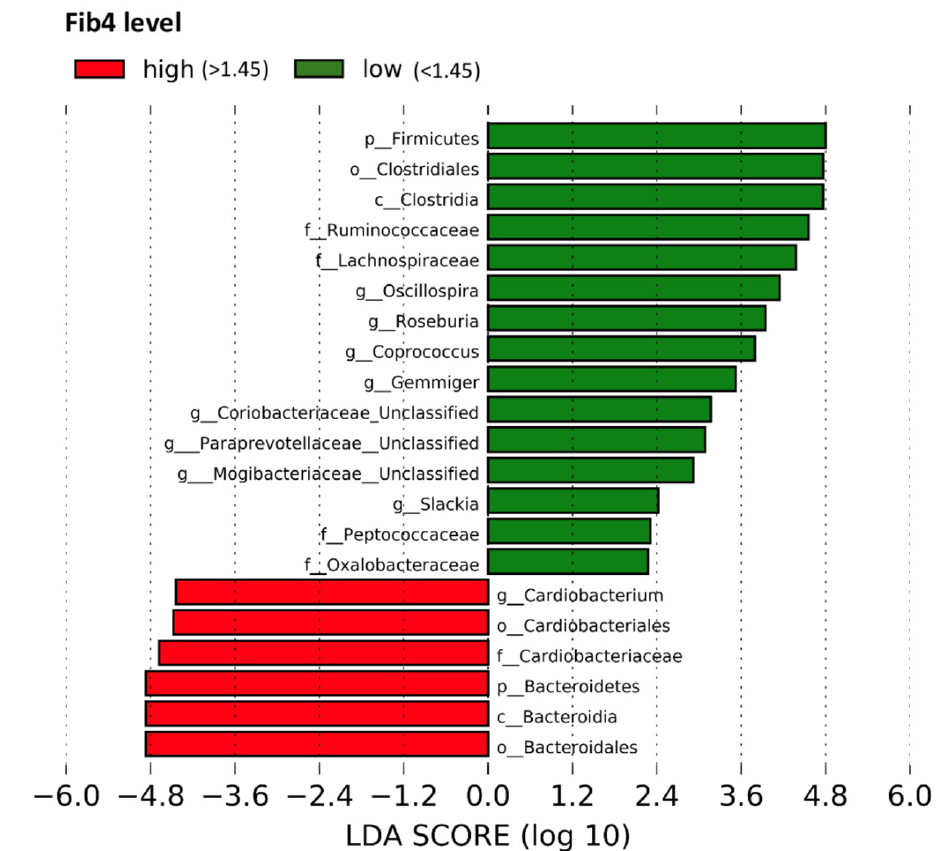
Figure 1. Differential relative abundance of participants with and without FIB-4 ≥ 1.45. Figure 1 displays the results of the LEfSe analysis, which identifies the most differentially abundant taxa between participants with and without FIB-4 ≥ 1.45. FIB-4 score ≥ 1.45 was defined as “unable to exclude advanced liver fibrosis/cirrhosis”. Taxa enriched in participants with FIB-4 < 1.45 are indicated with a positive LDA score in green, and taxa enriched participants with FIB-4 ≥ 1.45 are indicated with a negative score in red. Abbreviations: FIB-4, Fibrosis-4 Index; LDA, linear discriminant analysis; LEfSe, linear discriminant analysis effect